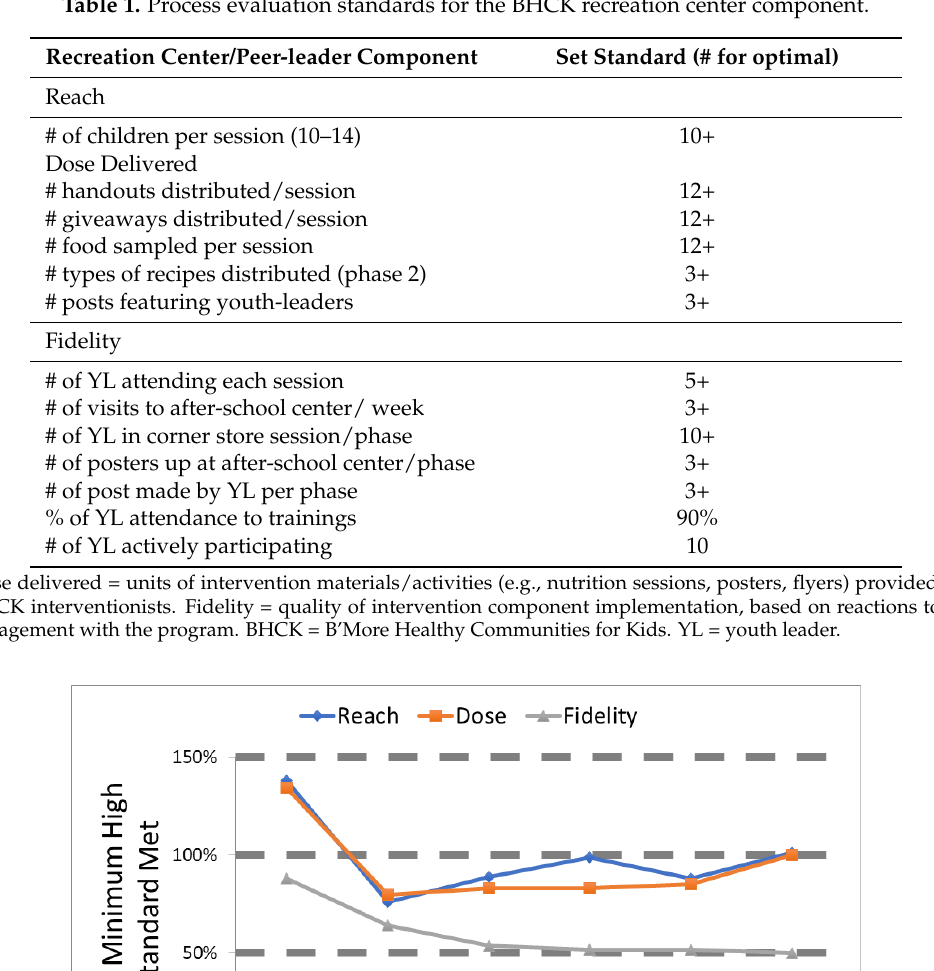
Table 1. Process evaluation standards for the BHCK recreation center component.